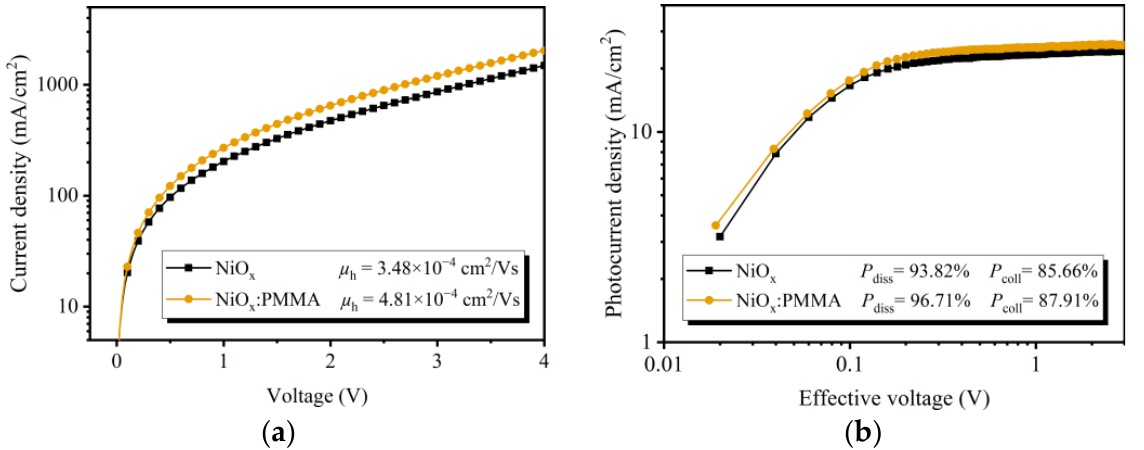
Figure 3. ( a ) J–V curves of the hole-only devices. ( b ) Photocurrent density dependence on effective